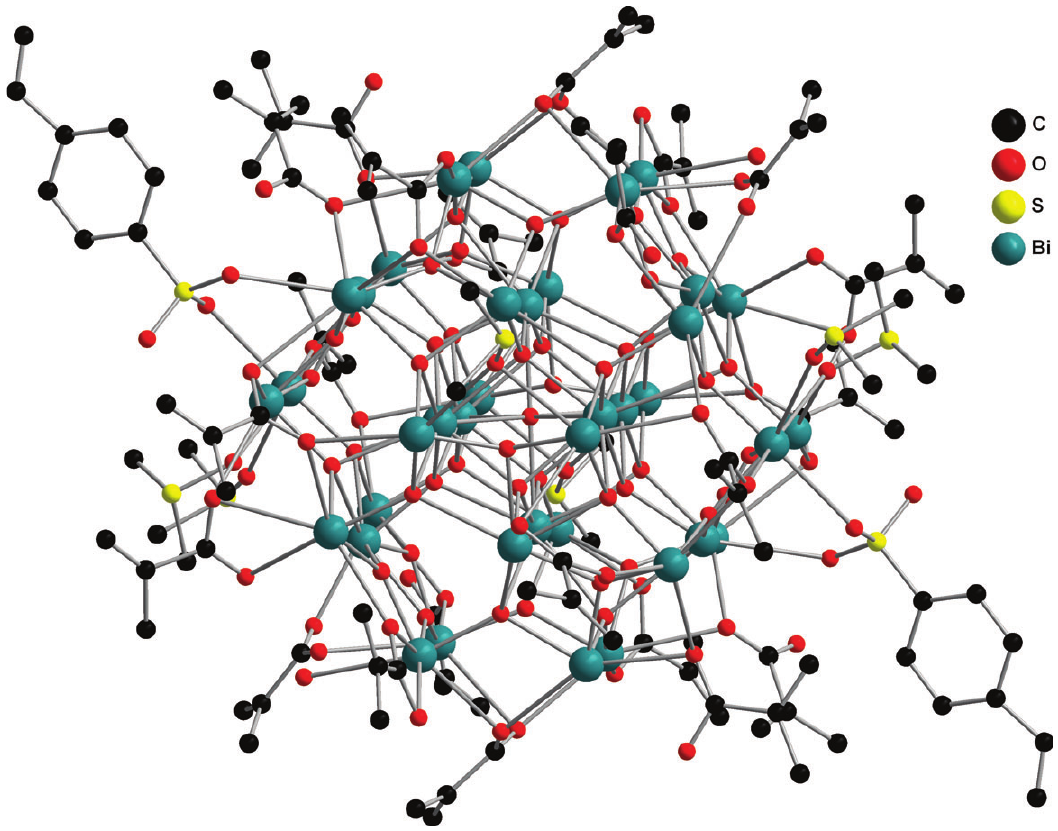
Figure 2 Ball-and-stick model of [Bi